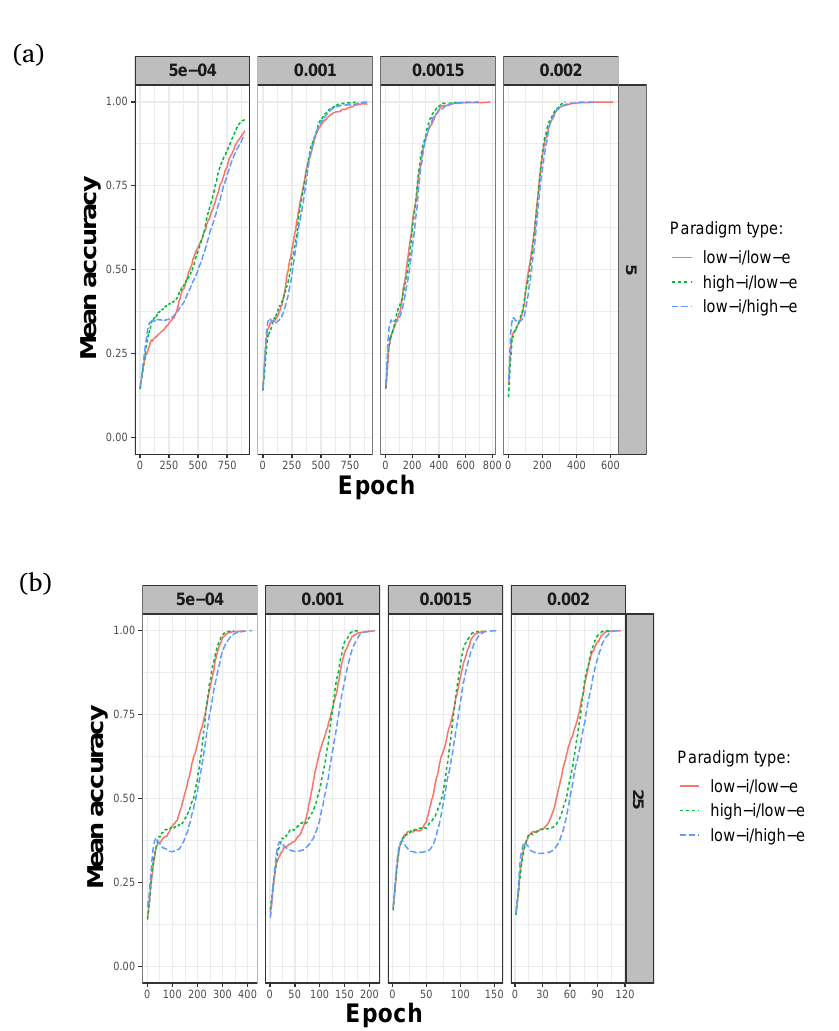
Figure 11: Learning trajectories of networks with two embedding and hidden layer dimensionalities; (a) networks with 5-dimensional embedding vectors and hidden layer, (b) networks with 25-dimentional embedding vectors and hidden layer, trained with different learning rates (columns), and optimized with Adam. X axis shows number of epochs up to perfect learning of the forms in the language (differs across learning rates and networks